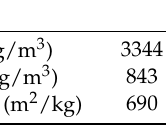
Table 2. Physical properties of used MgO powder.